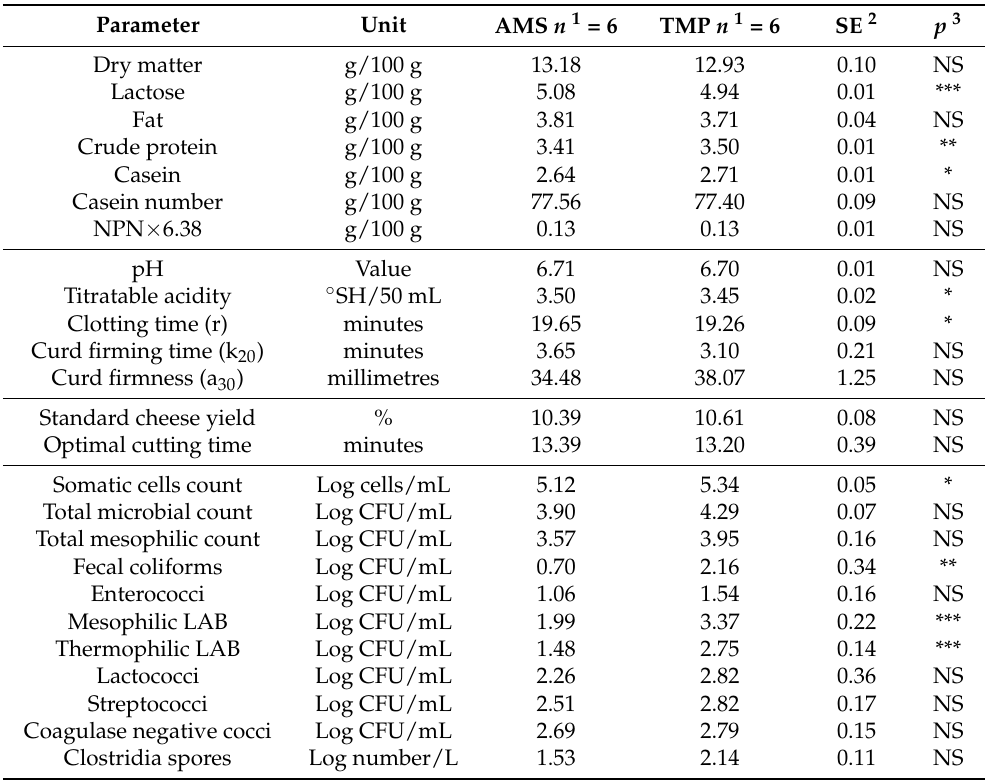
Table 2. Least square means of chemical composition parameters, rennet coagulation properties and microbial counts of herd whole milk milked with an automatic milking system (AMS) and with a traditional milking parlor